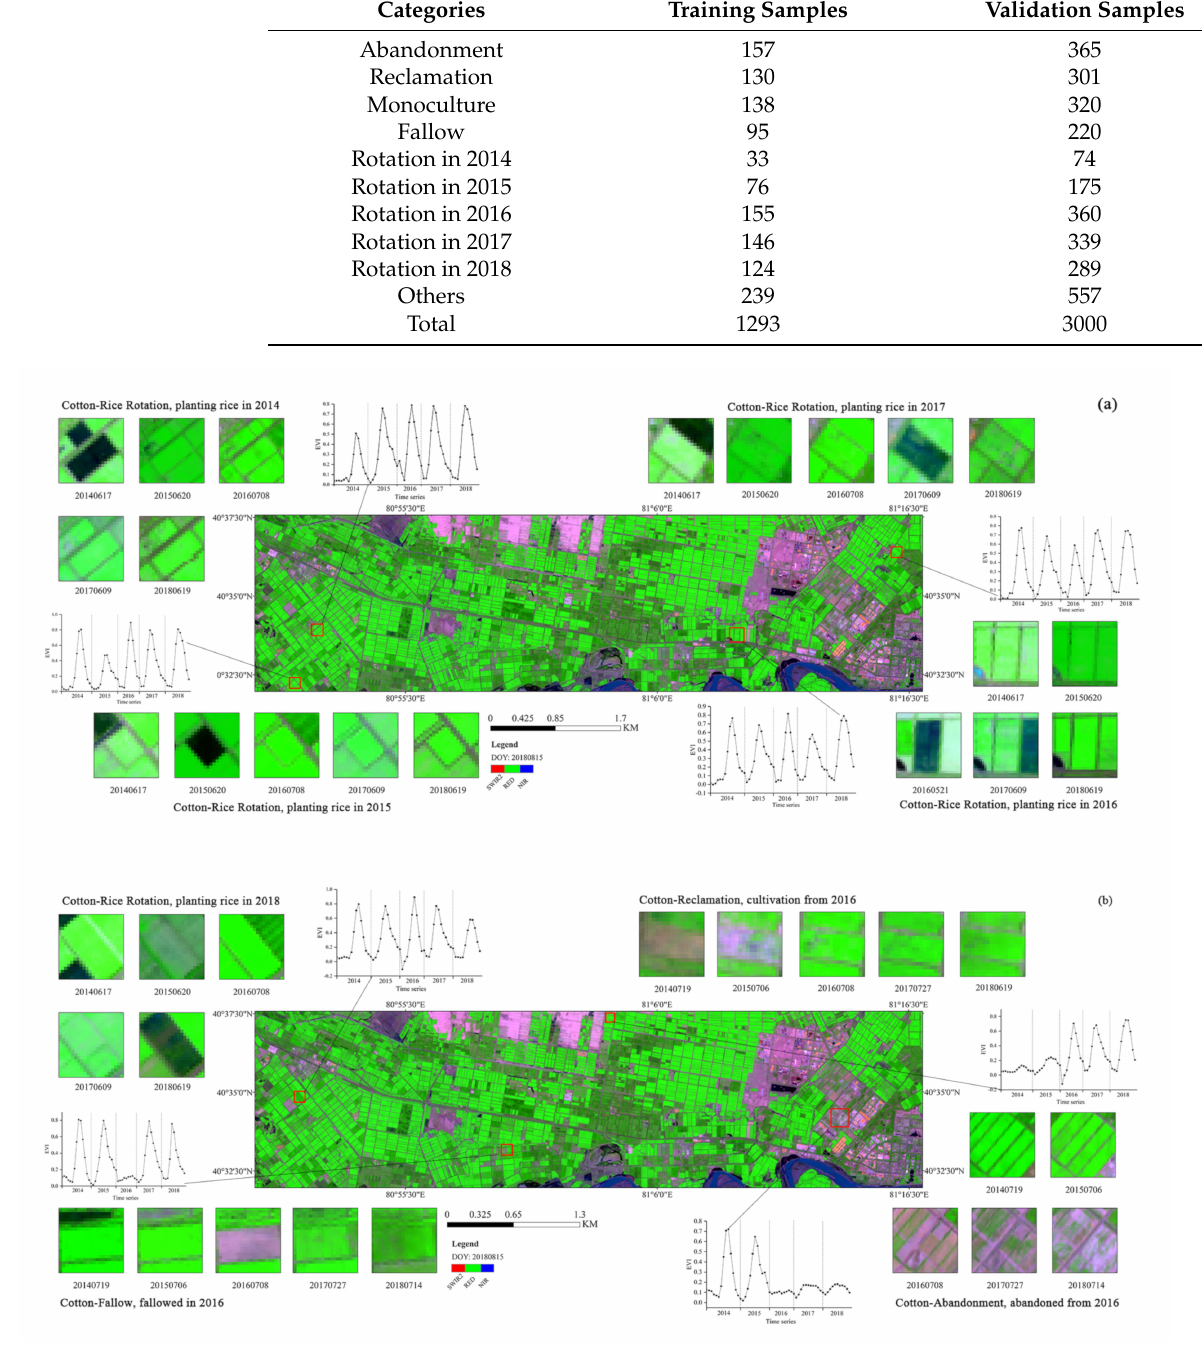
Figure 6. ( a ) Five-year temporal EVI of cotton-rice rotation. ( b ) Five-year temporal EVI of cotton succession (rotation, reclamation, fallow, and